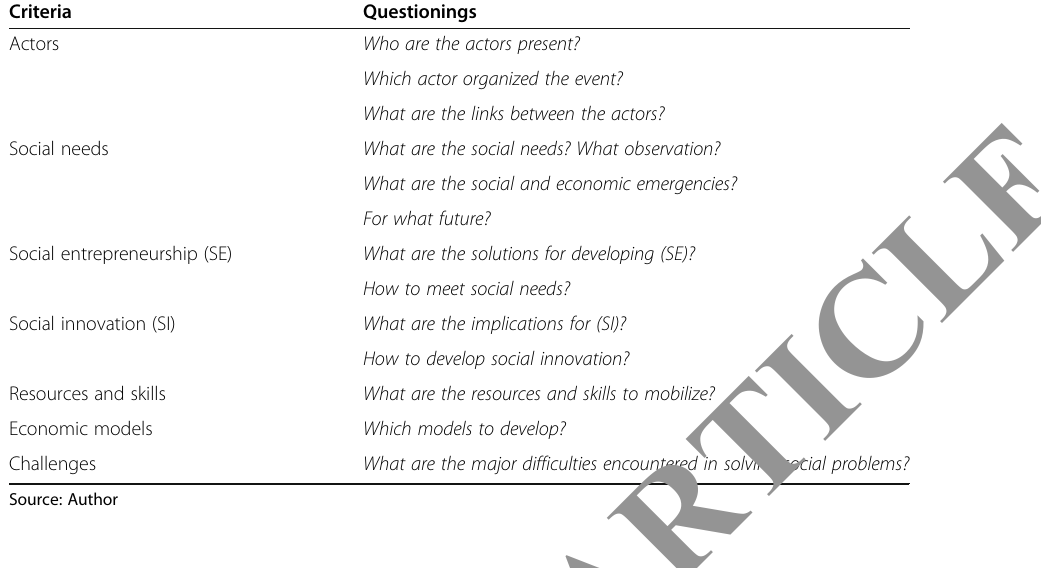
Table 2 Observation grid for social events